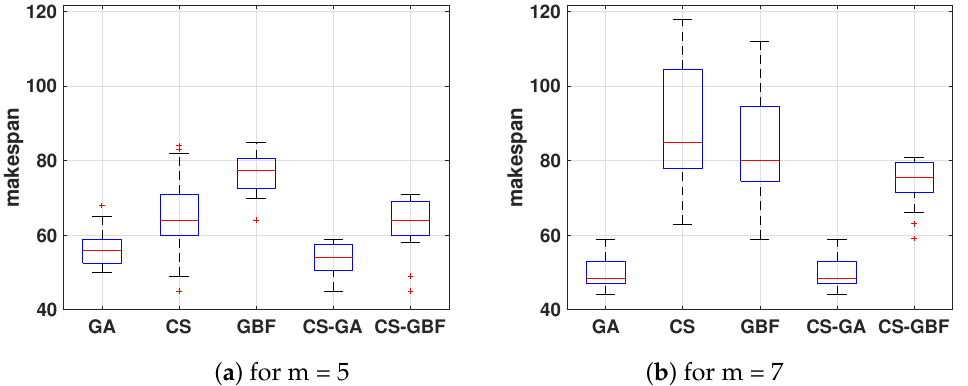
Figure 6. Performance of genetic algorithms (GA), crowdsourcing (CS), greedy best-first (GBF) search algorithm, and the merged approaches (CS-GA and CS-GBF) for solving the Open Shop Scheduling (OSS) for ( a ) m = 5, ( b ) m = 7